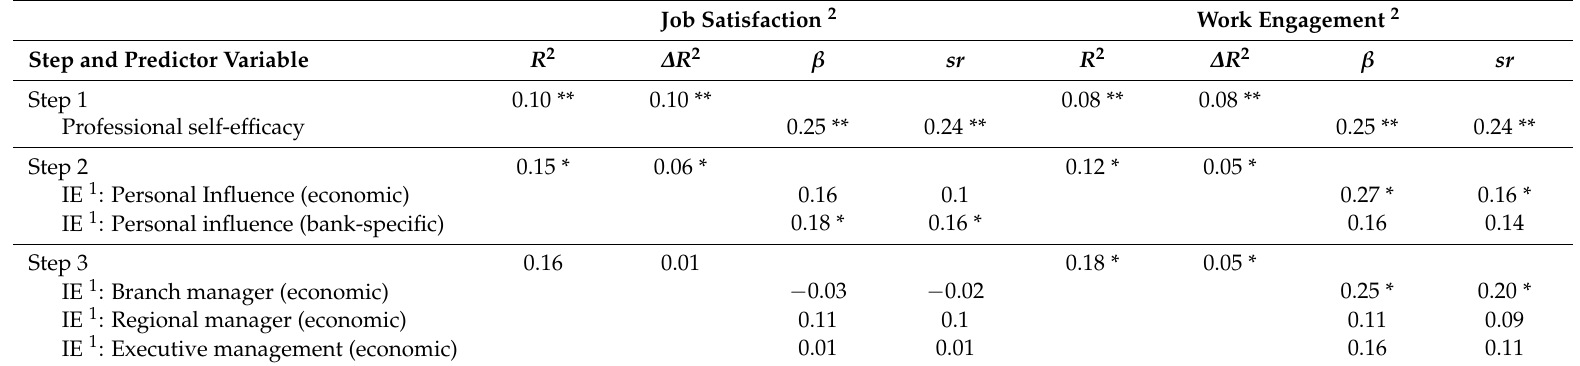
Table 3. Hierarchical regression analysis for job satisfaction and work engagement as outcome variables (N = 136). Job Satisfaction 2 Work Engagement